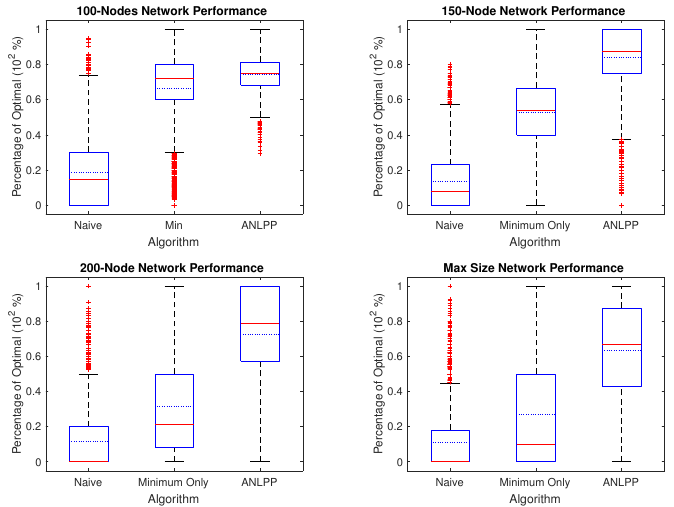
Figure 3. The performance of each algorithm over ten thousand networks of fixed size. The upper left image shows the results for a 100-node network, upper right 150-node, lower left 200-node, lower right maximum size to charge a single node (between 233 and